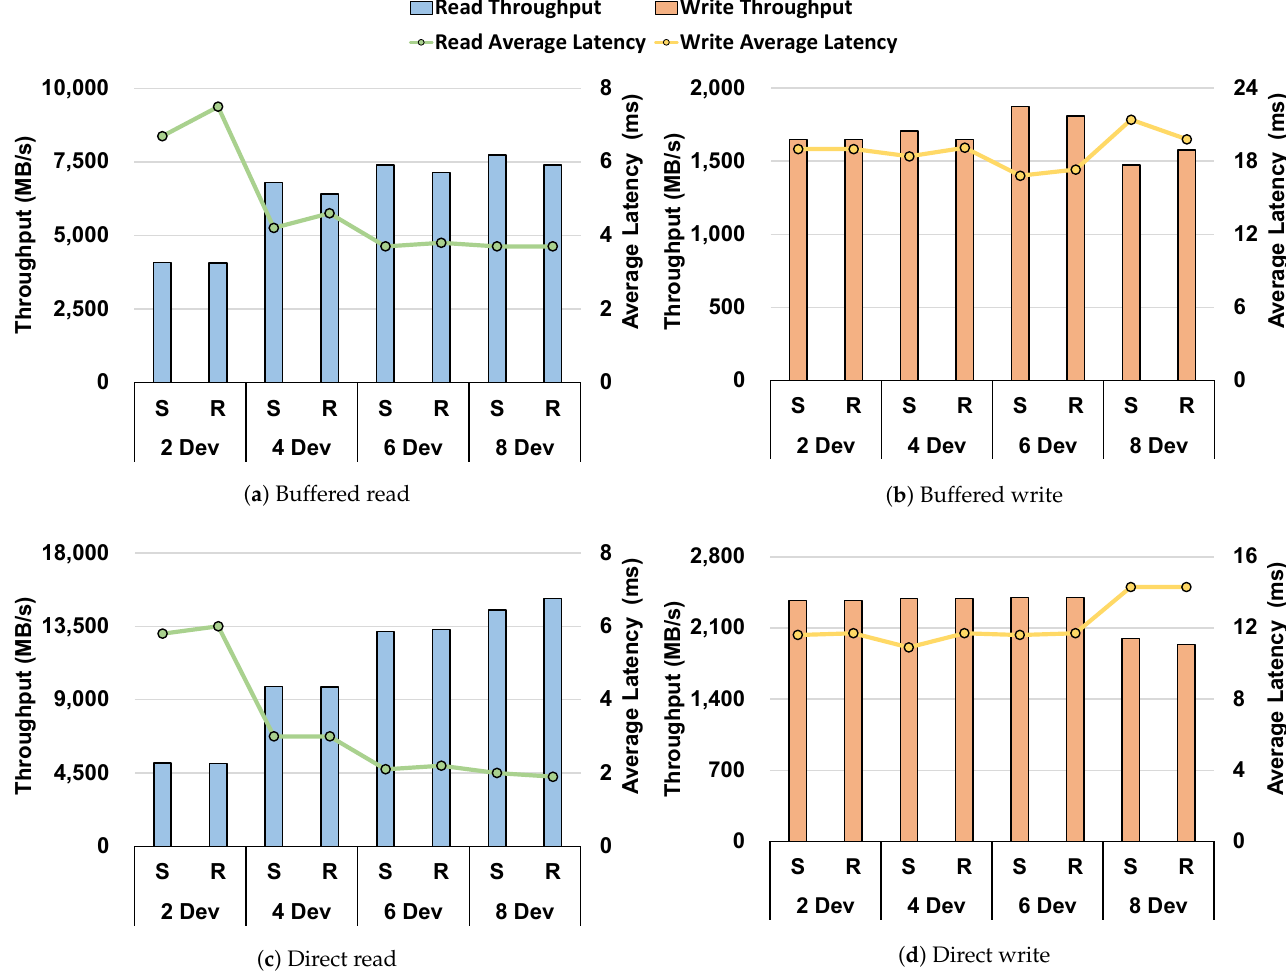
Figure 2. Experimental results under RAID 1 (S: sequential, R: random, Dev: number of